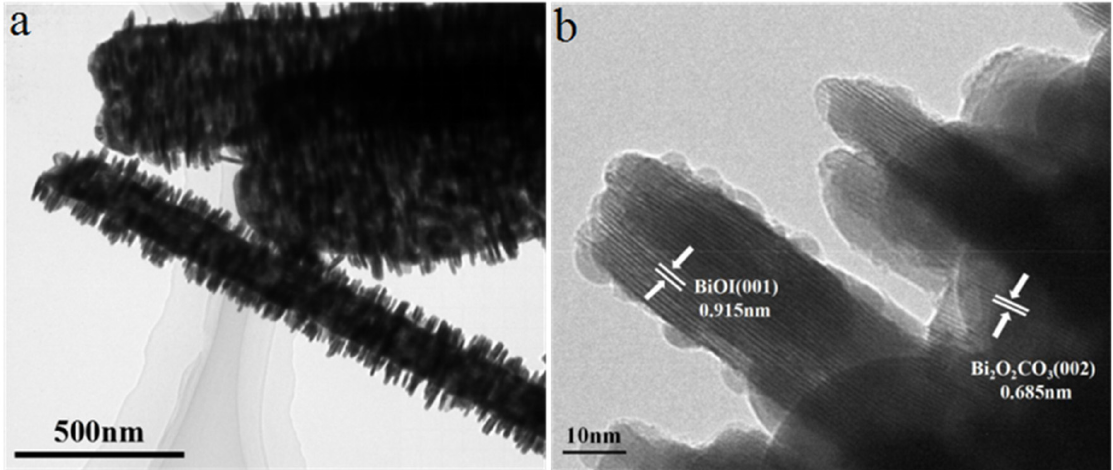
Figure 2. ( a ) TEM and ( b ) HRTEM images of the sample